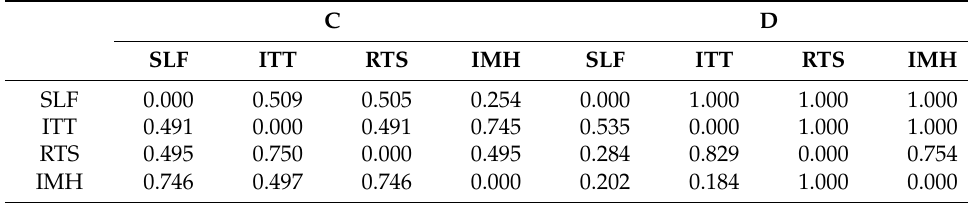
Table A18. C and D matrixes.